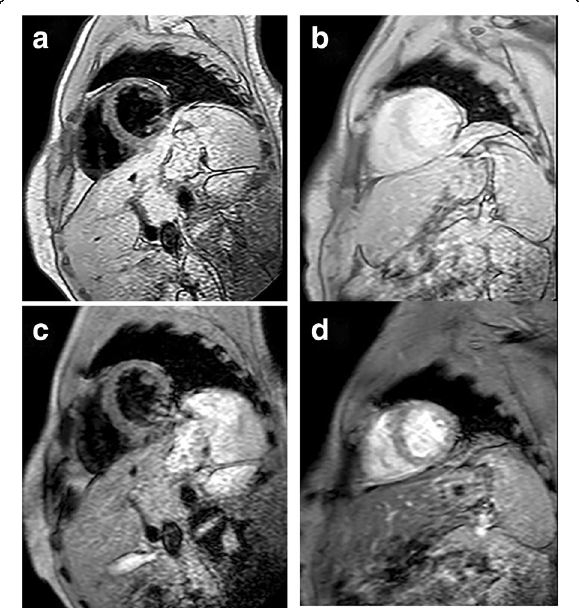
Fig. 2 Gradient echo black blood and white blood T2* static images acquired at TE 1.6 ms ( a , b ) and TE 18.8 ms ( c , d ) show no decay at T2* signals of the liver or the heart in a thalassemia major patient; normal values of the liver (T2* 18.4 ms, LIC 1.67 mg/g) and heart (T2* 50.4 ms and MIC 0.38 mg/g). The measured serum ferritin was 2000 ng/ml consistent with normal liver and heart findings